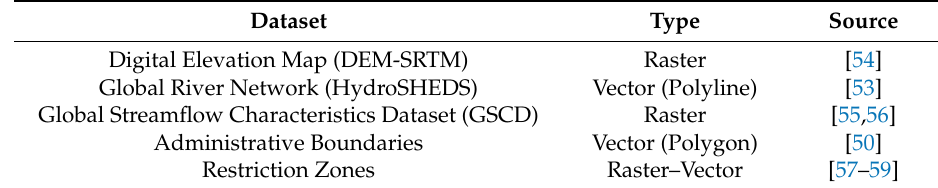
Table 1. List of Geographic Information Systems (GIS) datasets used for the mini-small hydropower assessment in Sub-Saharan Africa.